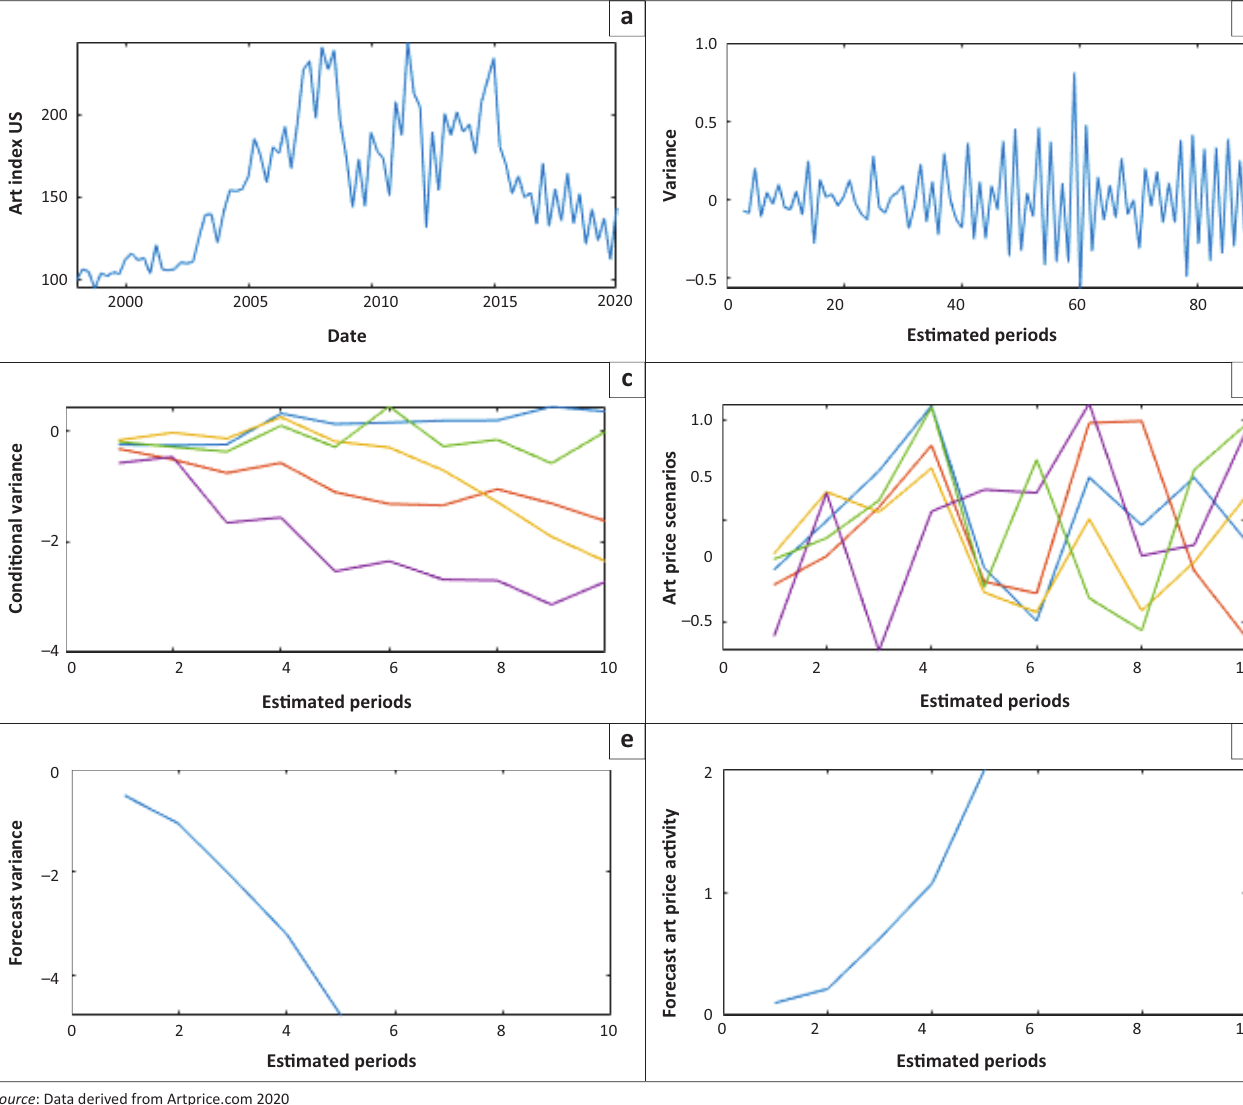
FIGURE 7a: Examining possible scenarios for the Global Art Price Index in United States Dollars. (a) Art price index US, (b) Variance API US, (c) Conditional variance 10 period esrimate, (d) 10 period simulation, (e) Conditional variance 5 period forecast, (f) 5 period